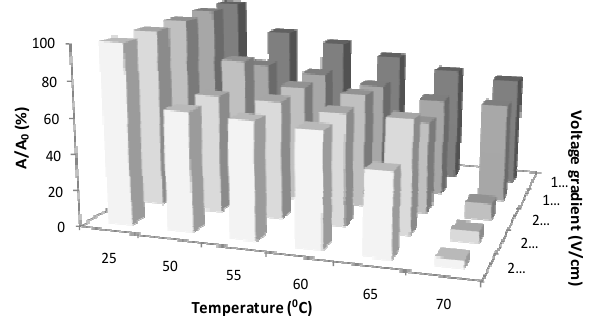
Fig. 3. The relative activity of PME crude extract after ohmic treatment at different temperatures and voltage gradient